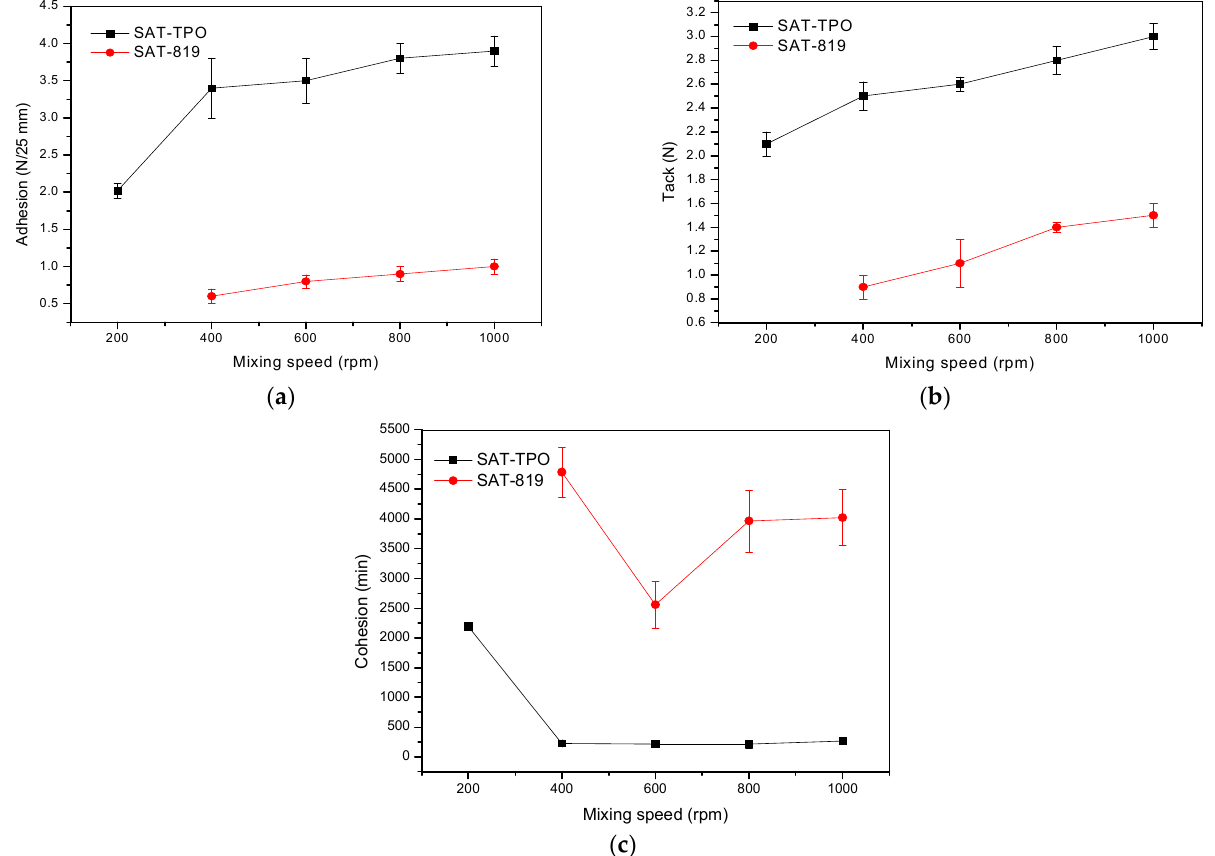
Figure 4. Self-adhesive features of the selected UV-crosslinked (thermally uncured) SATs: ( a ) adhesion to steel, ( b ) tack, and ( c ) cohesion at 20 ◦